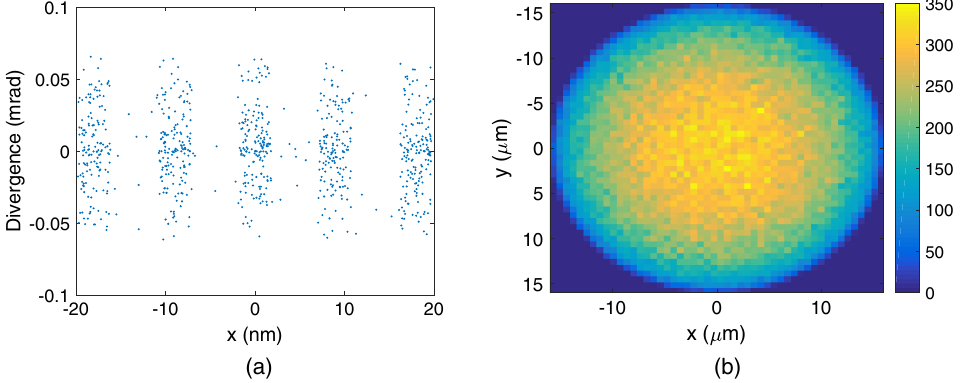
FIG. 5. (a) Individual electrons imaged after magnification and acceleration at the entrance of the EEX line. (b) Full transverse density profile of the electron bunch visualized as a two dimensional histogram of particle count in the simulation.